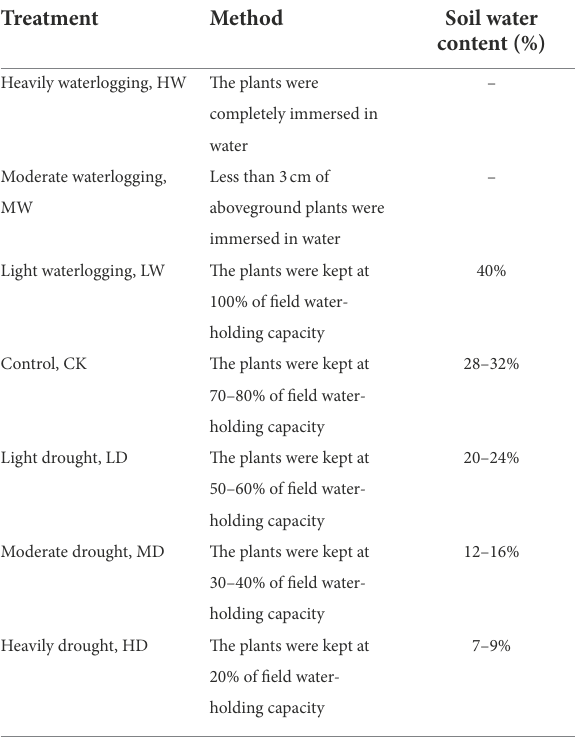
TABLE 1 Hydrological conditions used to examine the response of hairgrass ( Deschampsia caespitosa ).